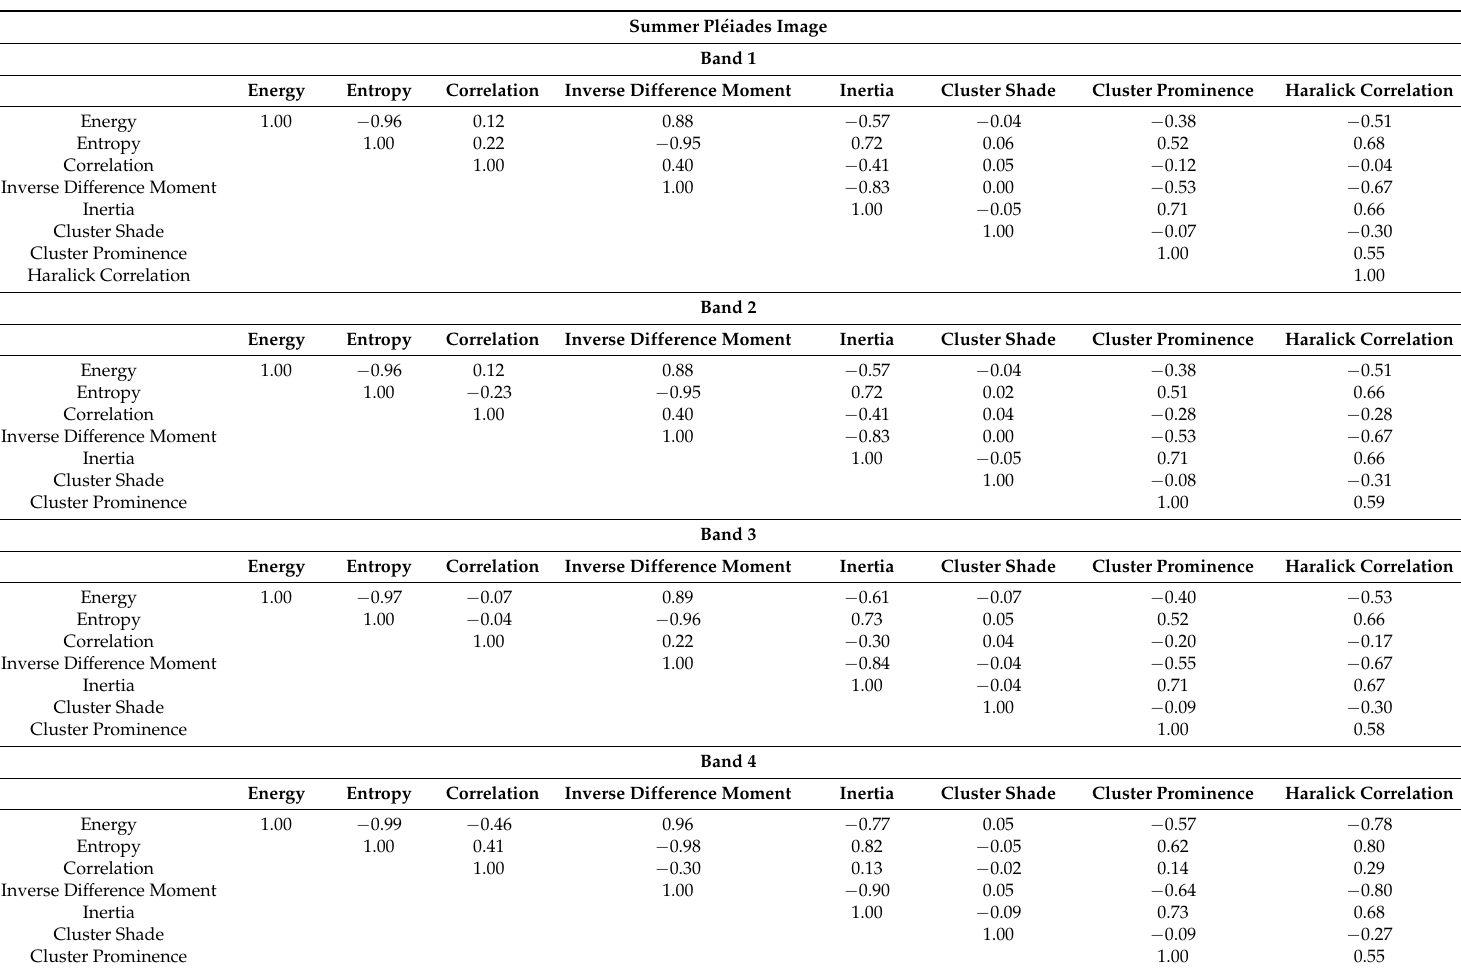
Table A1. Pearson’s correlation matrices for the features extracted from summer Pl é iades